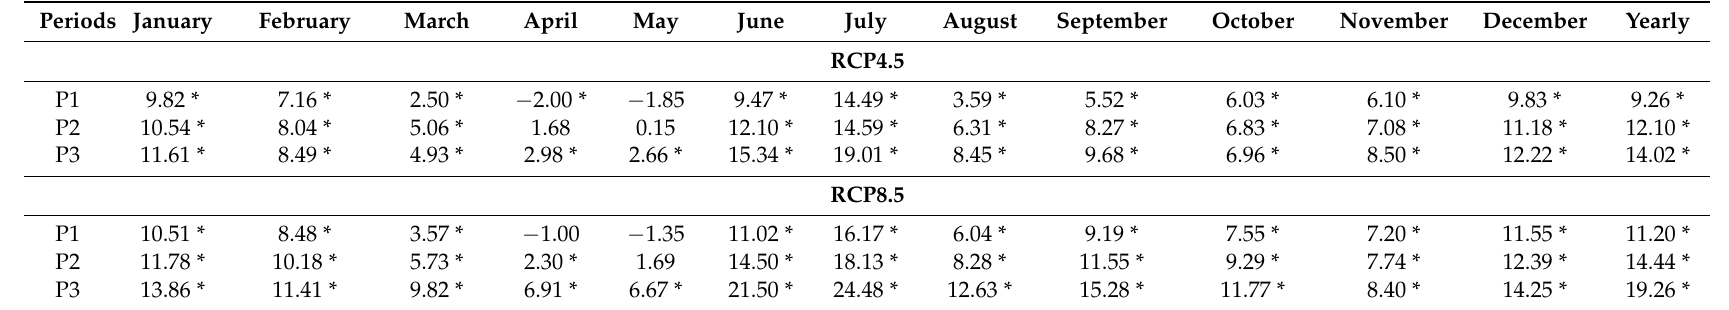
Table 5. Results of student’s t-test for